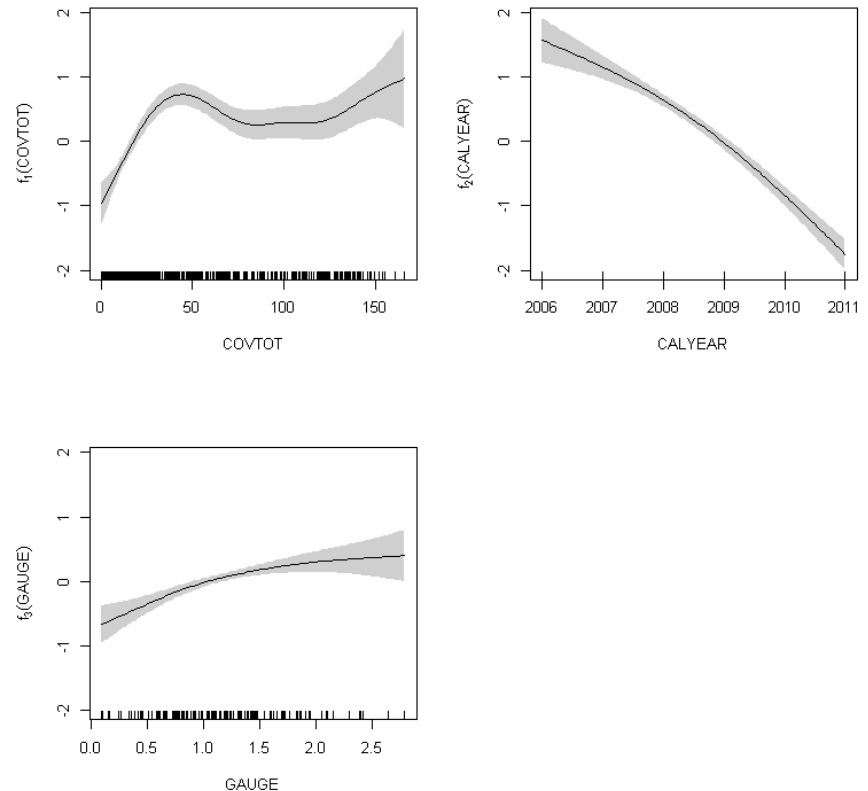
1098 Fig. 4. Nonlinear effects of the total degree of coverage (COVTOT), calendar year (CALYEAR), and groundwater level (GAUGE) on the Figure 4 1099 proportion of annual plants (PROPANN) (see Eq. 11). Shaded: 95%-confidence area. Table 7. Parameter estimates and significances for the model estimating the proportion of annual plants (PROPANN) as shown in Eq. (11). Significance levels: ***: p < 0.001, **: p < 0.01, *: p < 0.05. The variance of the random effect a in Eq. (11) is 0.1594. Trend: qualitative illustration of linear predictor variables’ significant influences. ↑ , ↓ : PROPANN increases (decreases) with increasing values of the respective predictor variable. Variable Trend Parameter Estimate Std. Error Significance α 0.2551 0.0868 CORGP Nonparametric smoother See Fig. 4 Nonparametric smoother See Fig. 4 Nonparametric smoother See Fig.